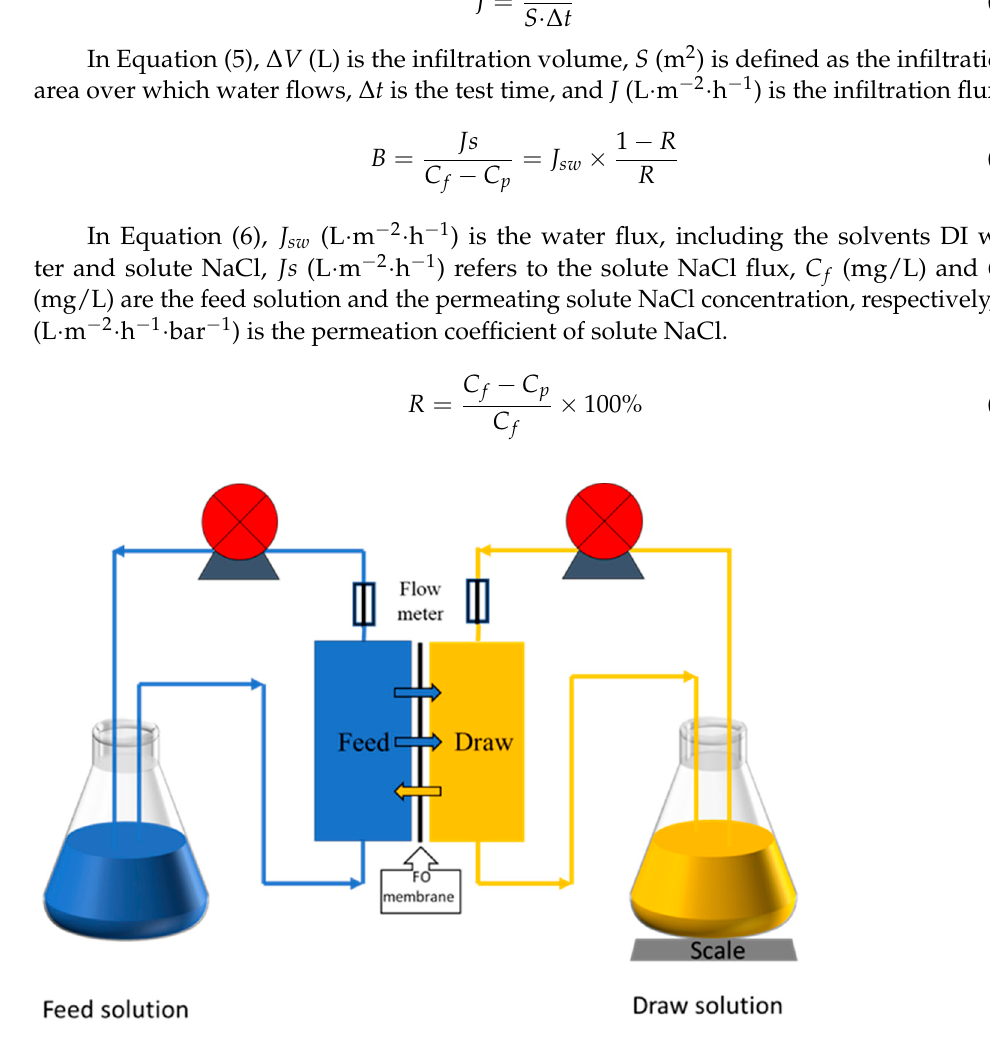
Figure 1. Schematic diagram of the FO experimental process.